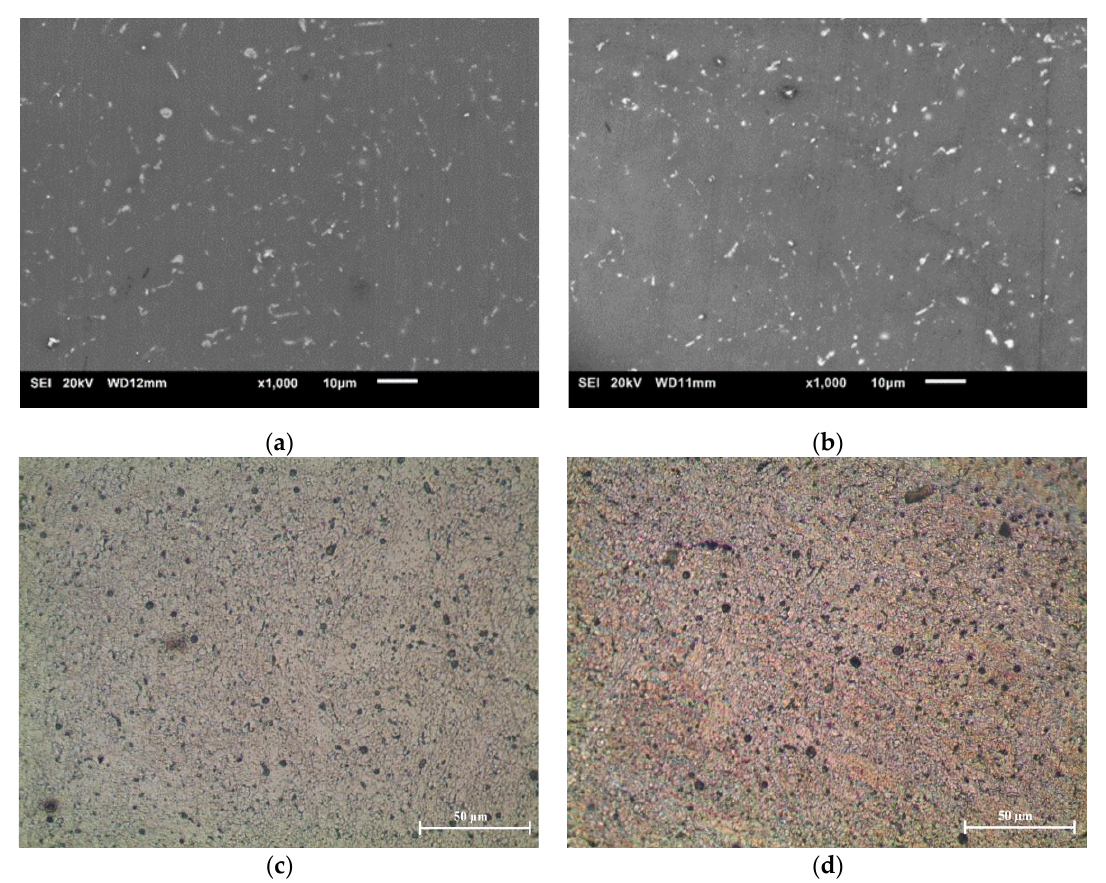
Figure 1. SEM micrographs showing the global distribution of ceria particles in ( a ) as-extruded and ( b ) as-extruded + DCT Mg/2wt.%CeO 2 samples. Optical micrograph of ( c ) as-extruded and ( d ) as extruded + DCT Mg/2wt.%CeO 2 samples.